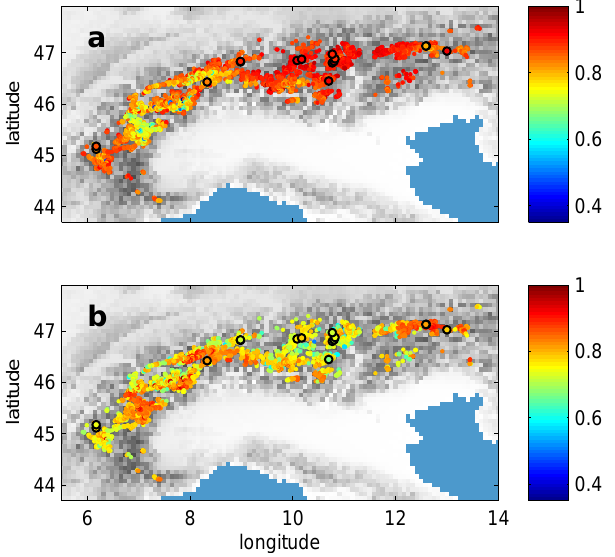
Fig. 10. Maps of correlation between reconstructed mass balance variability and mass balance variability driven only by temperature variability (a) and mass balance variability driven only by precipi- tation variability (b) , for all glacier within the Alps included in the WGI-XF. Circled dots indicate the location and values of the mea- sured glaciers included in the final set. Background shading shows the topography of the HISTALP data set.